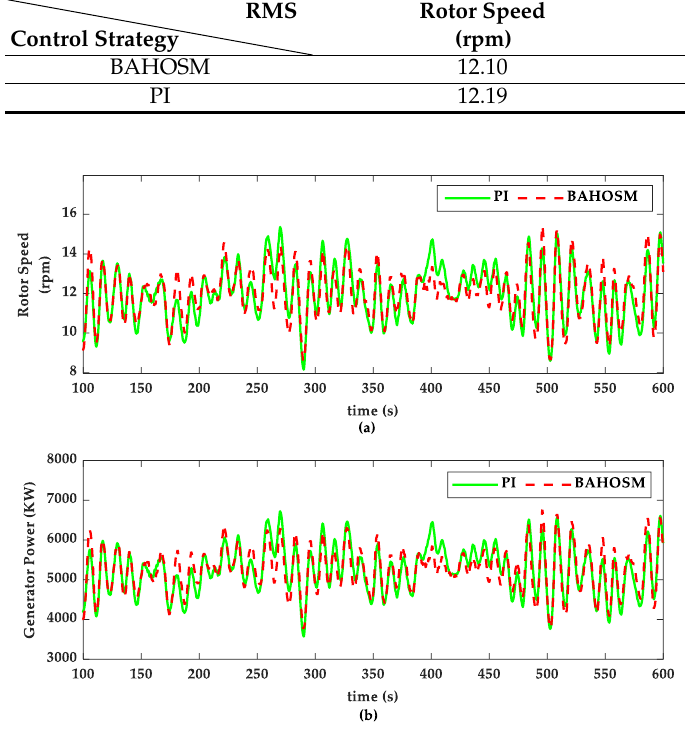
Figure 5. Rotor speed ( a ) and generator power response ( b ) in Case 2. Table 4. RMS values of the rotor speed and generator power for Case 2.